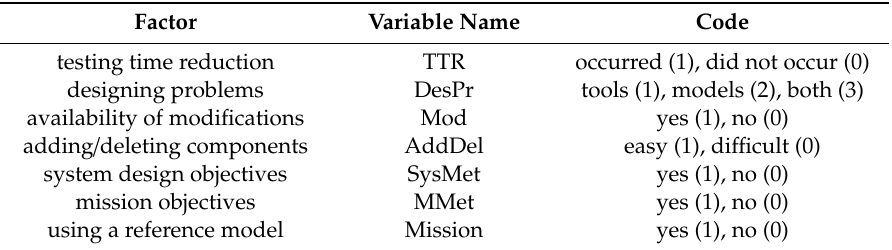
Table 1. The factors associated with CubeSat success /